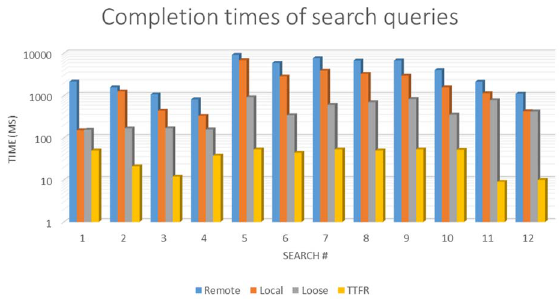
Figure 7. Latency benchmarks. We benchmark completion times of searches for: (Remote) low ( , 0.6 A˚) RMSD cutoff queries against our public server, (Local) low RMSD cutoff queries against a local server, and (Loose) queries with a default RMSD cutoff (1.0 A˚) against a local server. We also measure the time to first result (TTFR) under the same conditions as (Loose) queries. Each query corresponds to a specific search illustrated in the Results section and the query PDB files are included as part of the benchmark suite of suns-cmd (Software